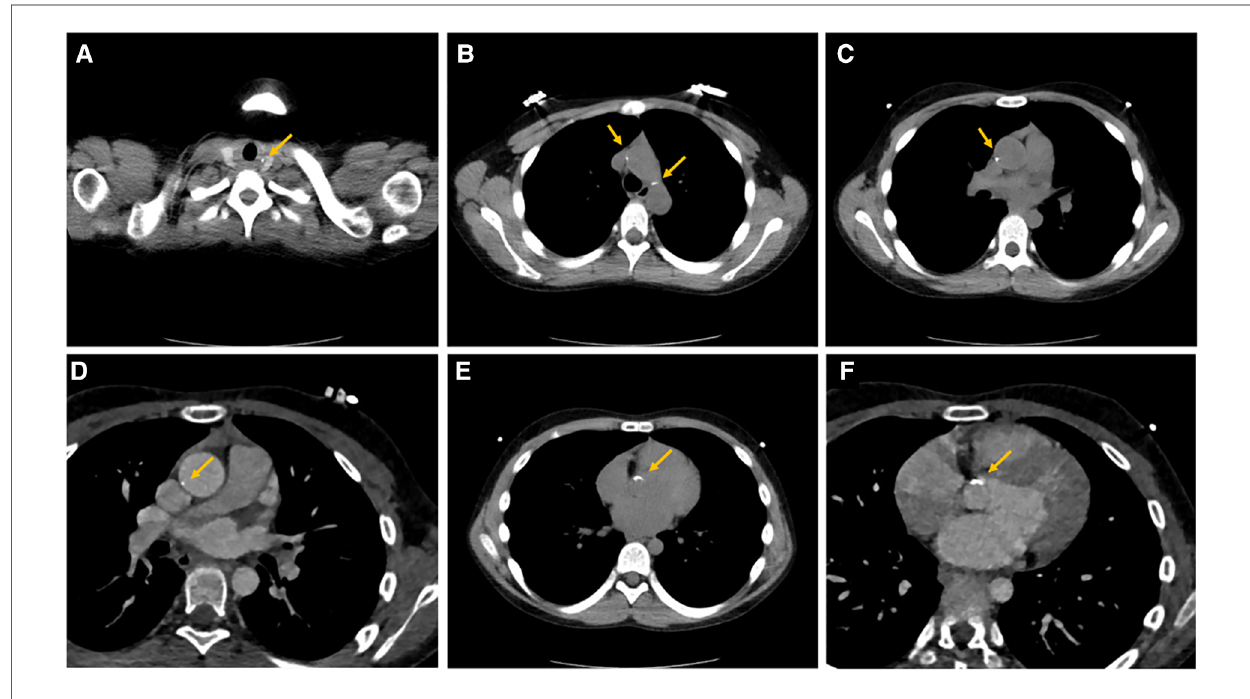
FIGURE 1 Calci fi cations of multiple vascular walls. Calci fi cation foci of the aortic arch ( A,B ) and ascending aorta ( C – F ) disseminated in the arterial